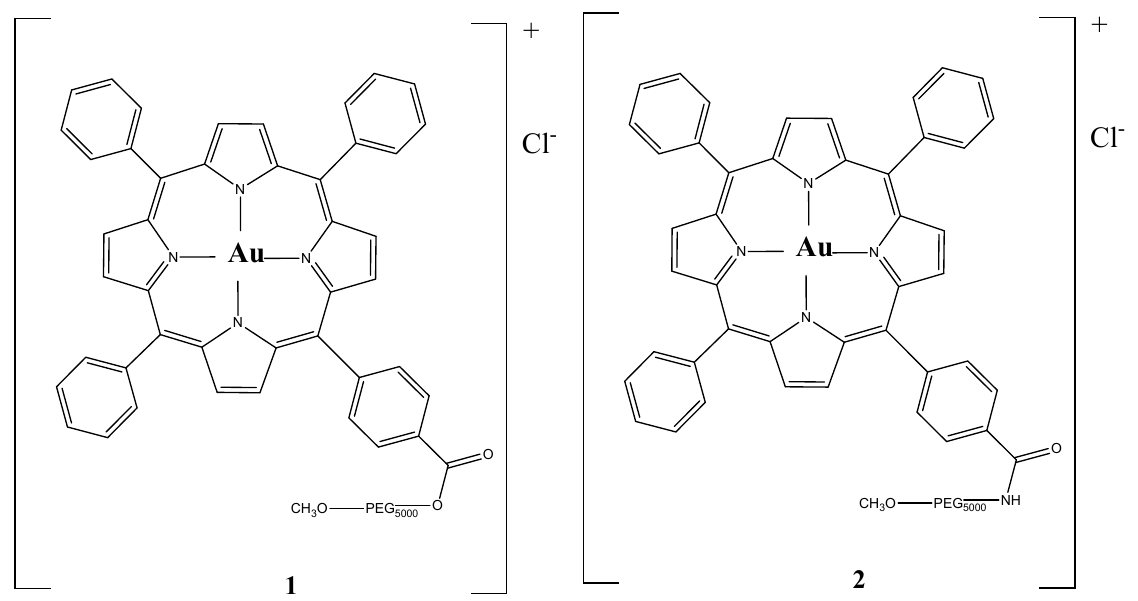
Figure 19. Chemical structures of [Au(TPP–COO–PEG5000–OCH 3 )]Cl (1) and [Au(TPP–CONH–PEG5000–OCH 3 )]Cl (2) [113].